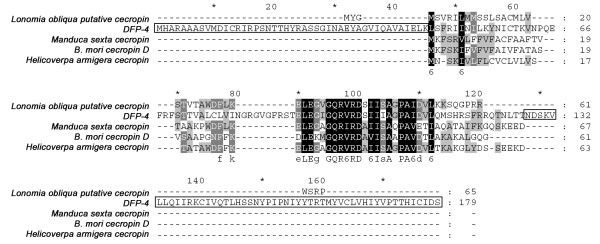
Multiple sequence alignment of DFP-4 with cecropins from other lepidopterans. L. obliqua putative cecropin [GenBank:AAV91462], M. sexta cecropin [GenBank:AAO74638], B. mori cecropin D [GenBank:BAE53371], Helicoverpa armigera cecropin [GenBank:AAX51193.1]. The unique regions of DFP-4 (no homology to cecropins) are boxed.